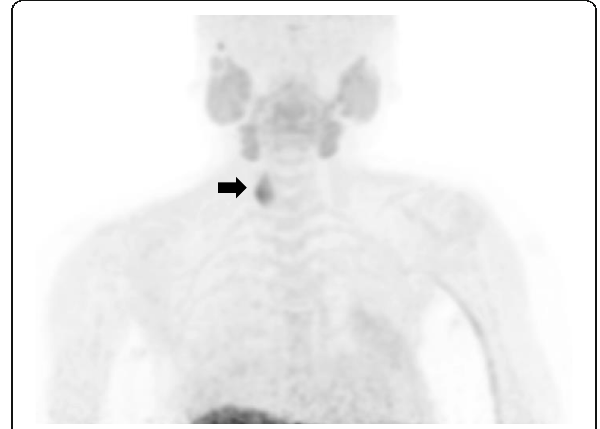
Fig. 5 11 C-methionine PET-CT findings after the removal of the upper and lower parathyroid glands. Methionine-positive tumor right next to the trachea